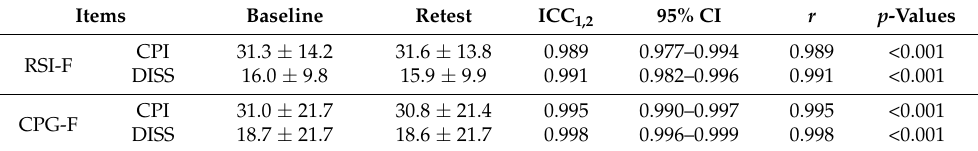
Table 2. Descriptive statistics of RSI-F CPI/DISS and CPG-F CPI/DISS at baseline and